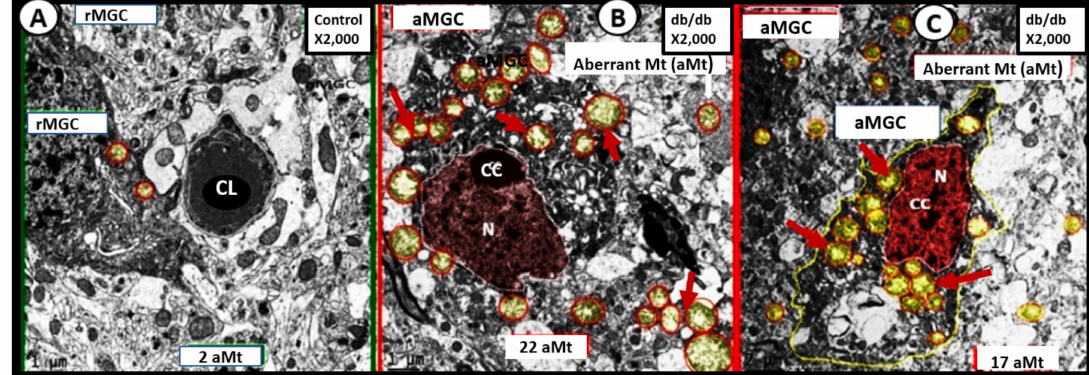
Figure 11. Aberrant mitochondria (aMt) in activated microglia cell(s) (MGCs) in the 20-week-old female diabetic db/db models. Panel A demonstrates a ramified MGC (rMGC) interacting with the neurovascular unit (NVU) in the control model. Panel B depicts an activated MGC (aMGC) with numerous aMt (pseudo-colored yellow with encircling red lines) in the diabetic db/db model. Note chromatin condensation (CC) within the nucleus (pseudo-colored red) (N). Panel C further depicts aMt and note that there is chromatin condensation within the pseudo-colored red nucleus (CC) in the female diabetic db/db model ( panels B and C ). Images provided by CC 4.0 [33,36]. CL = capillary